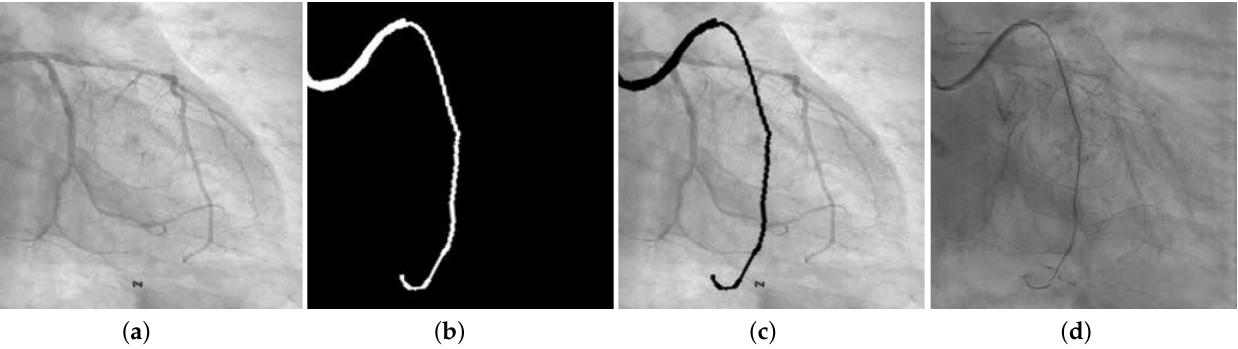
Figure 3. ( a ) X-ray image without catheter ( b ) random groundtruth ( c ) composited X-ray with groundtruth ( d ) generated X-ray image with catheter.